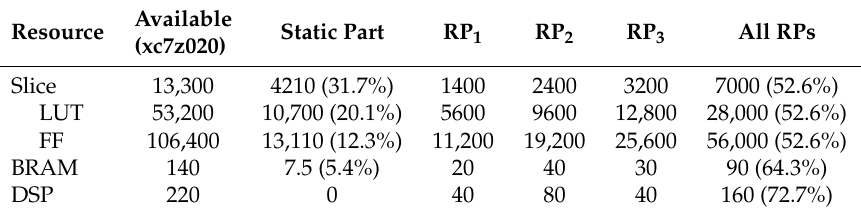
Table 3. Post-implementation resource utilization for the static and reconfigurable system parts. The figures in parenthesis correspond to the percentage of available FPGA resources.